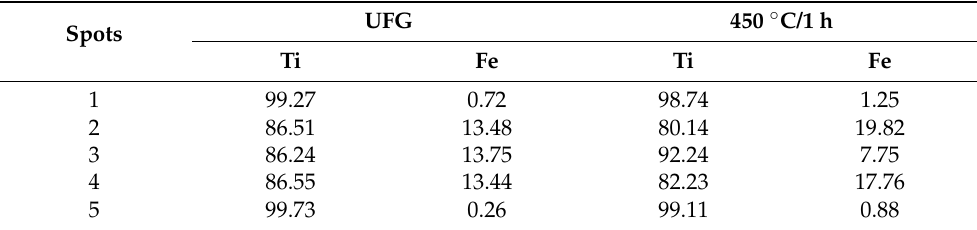
Figure 10. EDS spot measurements showing the chemical compositions of ( a ) the UFG alloy and ( b ) the alloy annealed at 450 °C for 1 h. Table 1. Chemical compositions (wt.%) at spots 1–5 according to the EDS spot measurements.